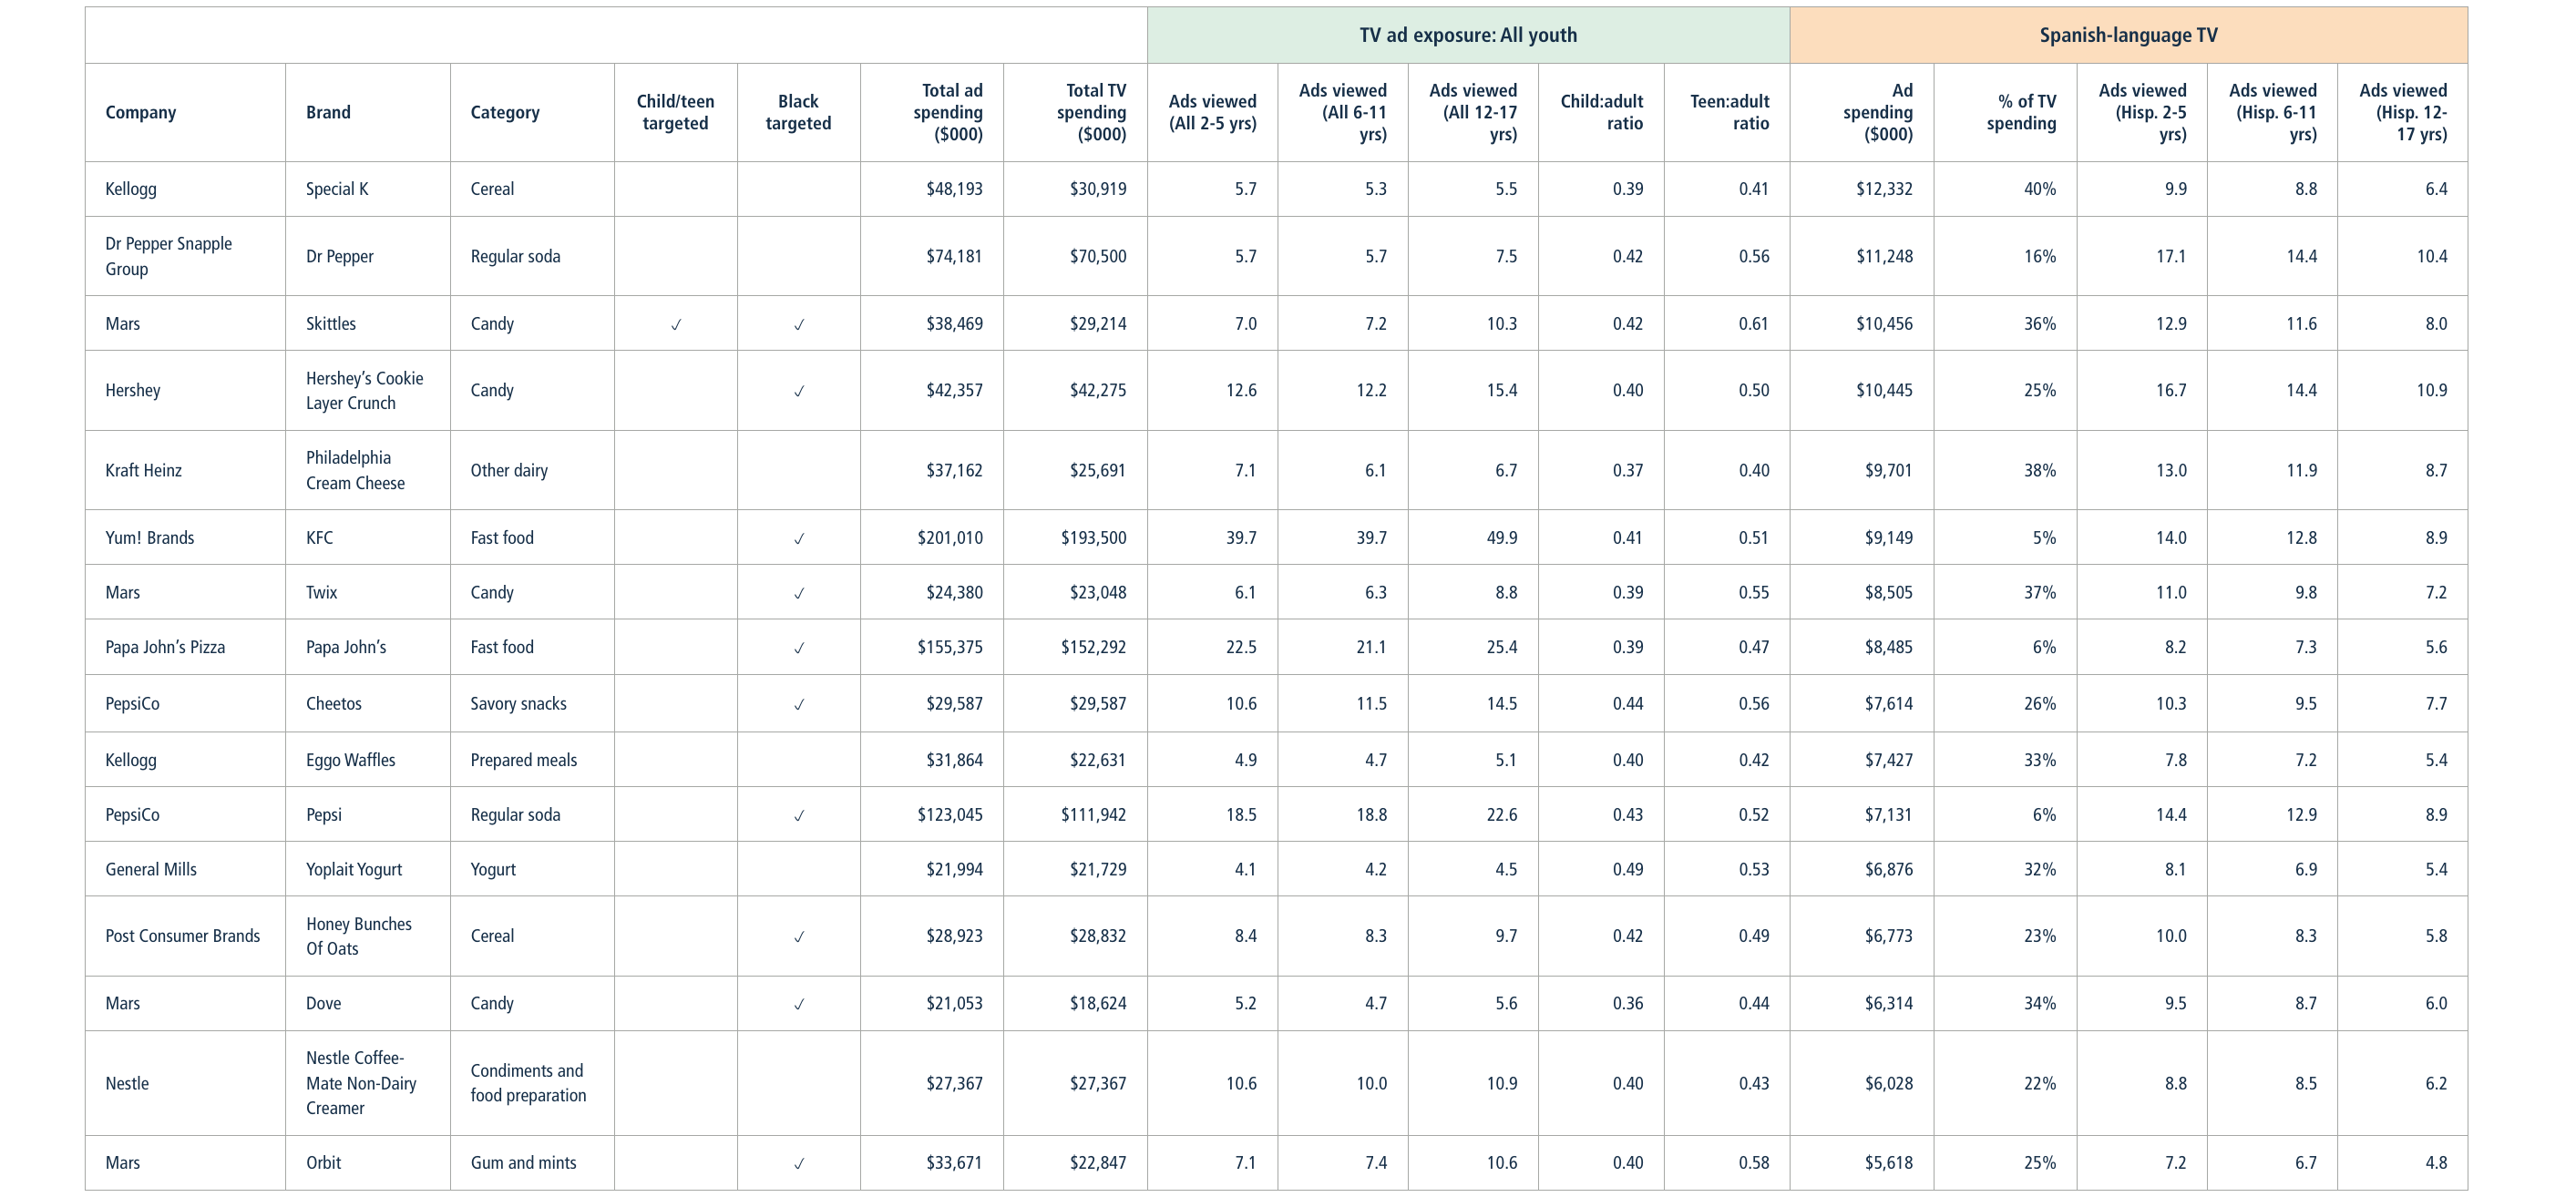
TABLE 2. BRANDS TARGETED TO HISPANIC CONSUMERS